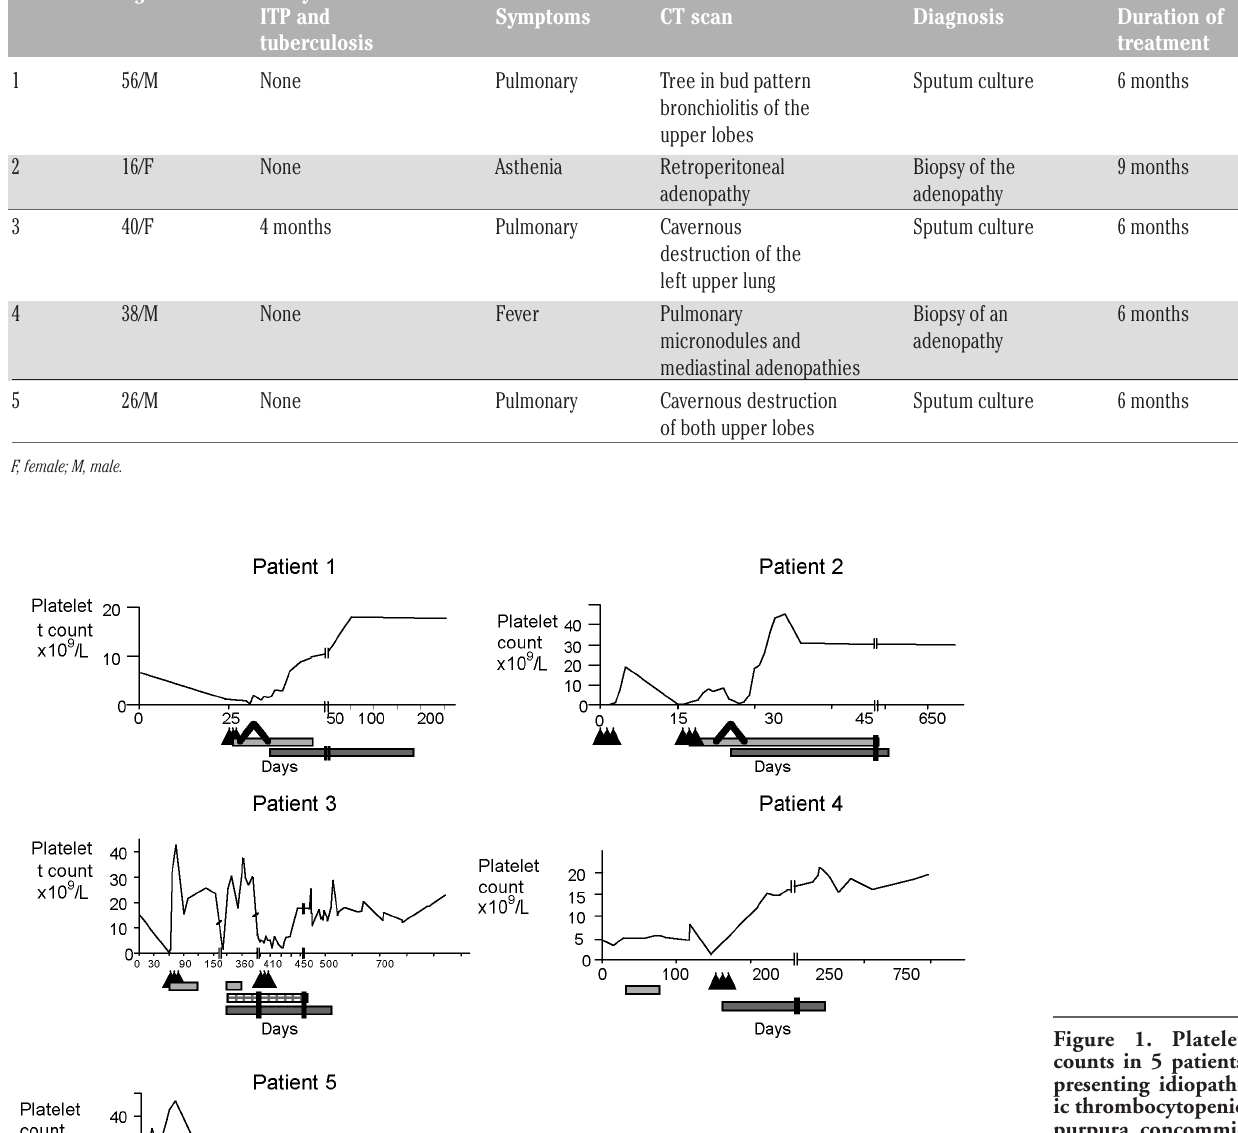
Figure 1. Platelet counts in 5